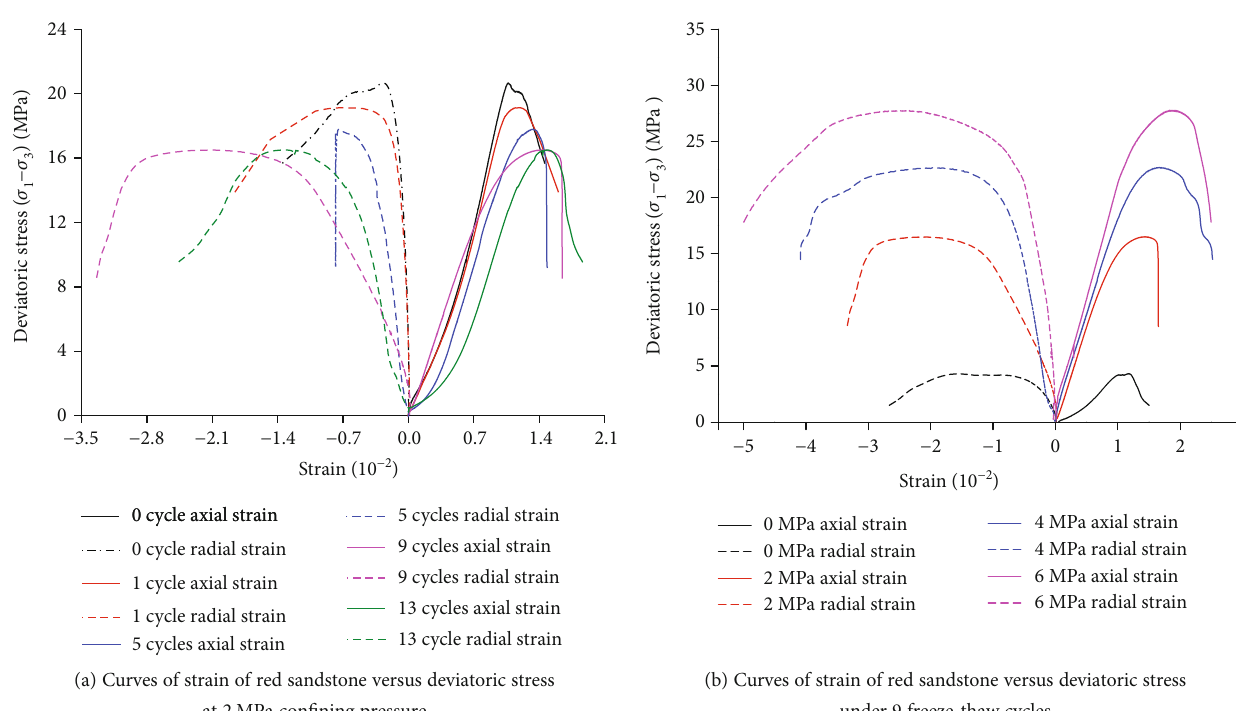
Figure 7: Curves of the tested red sandstone strain versus the applied deviatoric stress level for di ff erent (a) numbers of freeze-thaw cycles and (b) con fi ning pressures.